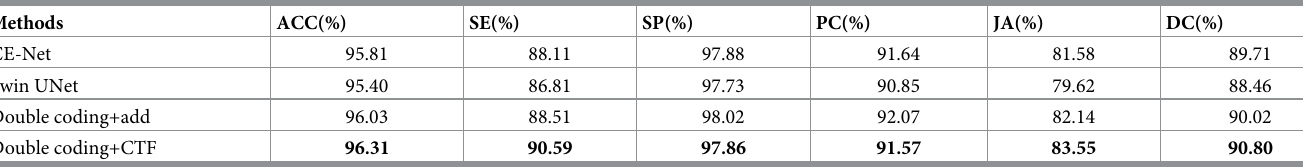
Table 3. The ablation experiment based on ISIC2018.